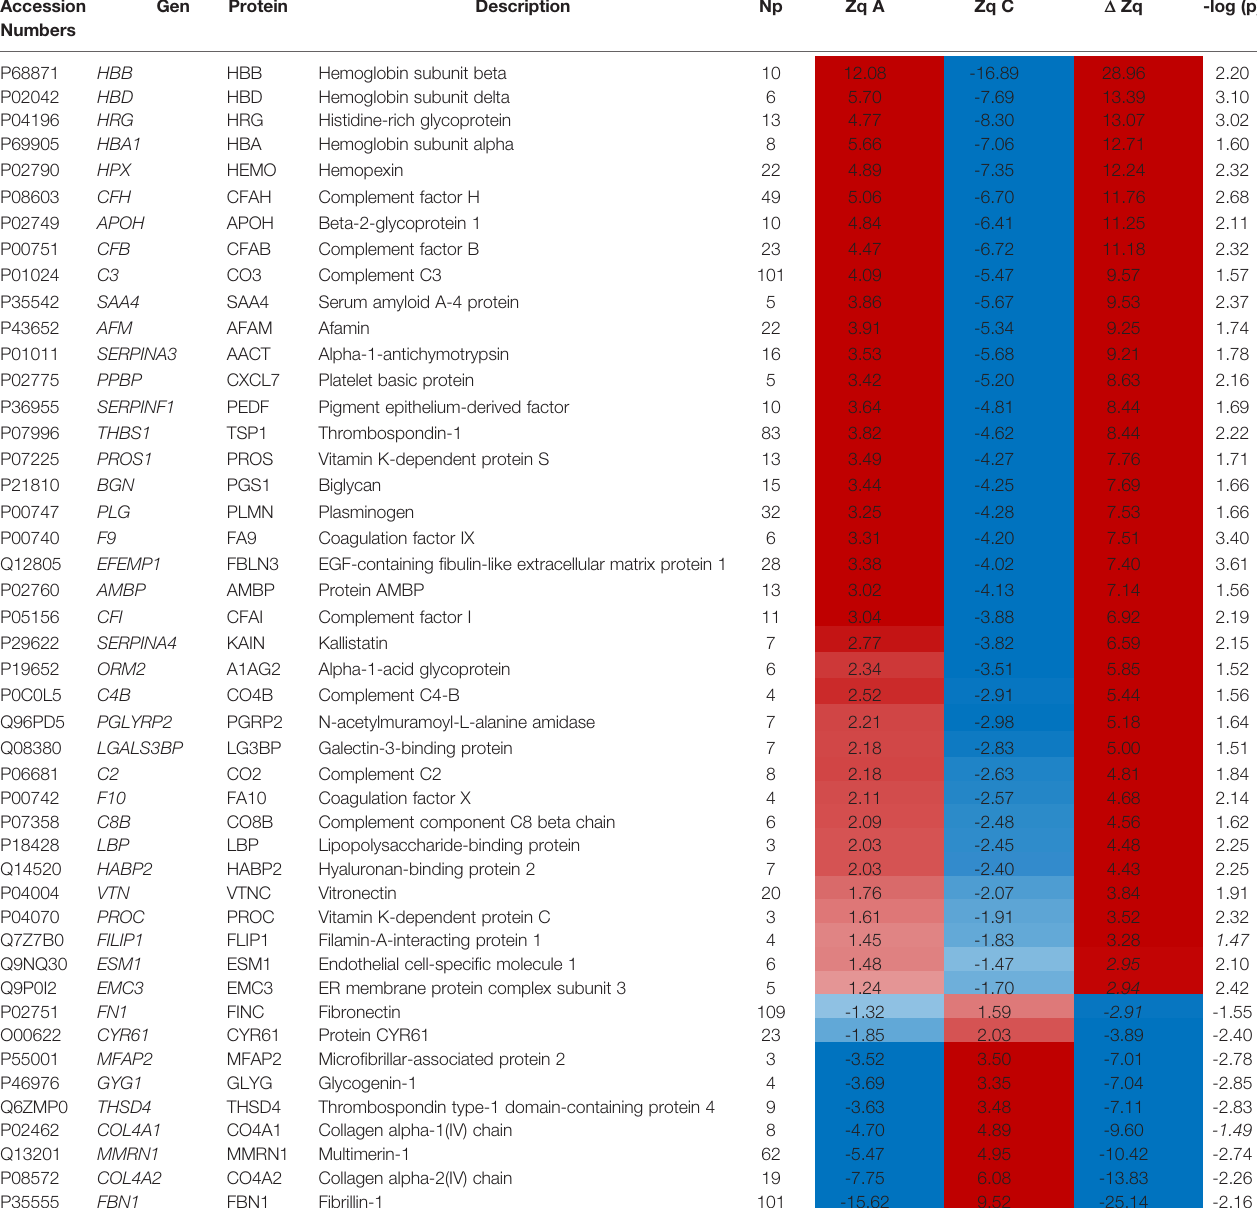
The color scale represents the increase (red) and decrease (blue) of each condition. Np, number of peptides; A, EC-anaphylaxis group; C, EC-control group; Zq, average of abundance values; D Zq mean difference of the values. Established criterion Np ≥ 3, | D Zq| ≥ 3, |-log (p) | ≥